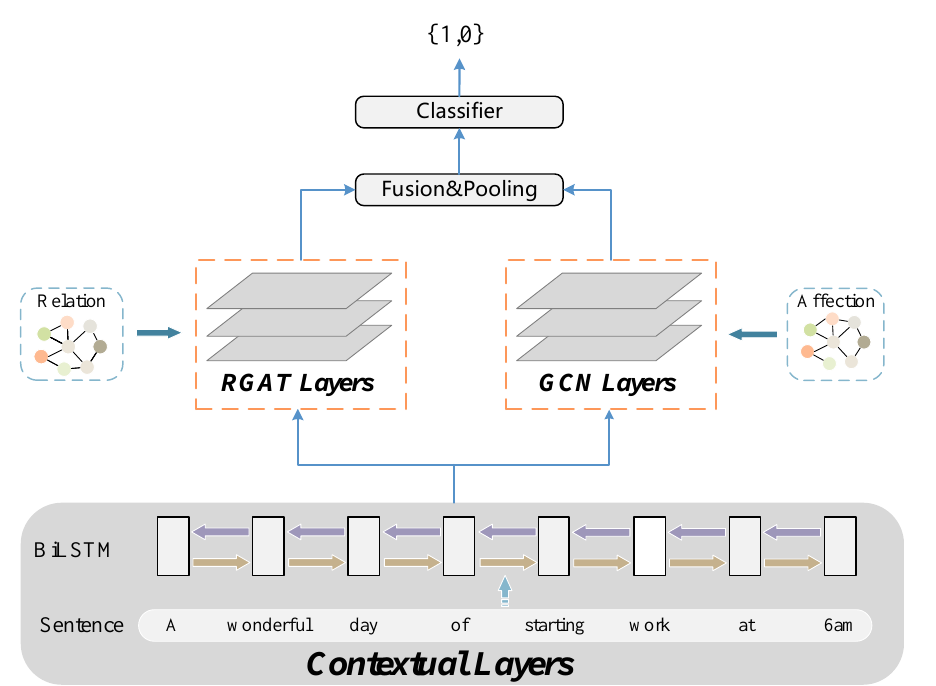
Figure 2. Architecture of the proposed ARGAT framework for sarcasm detection. It consists of a contextual encoder, RGAT layers, GCN layers and a classifier. The RGAT layers and GCN layers can be stacked to n